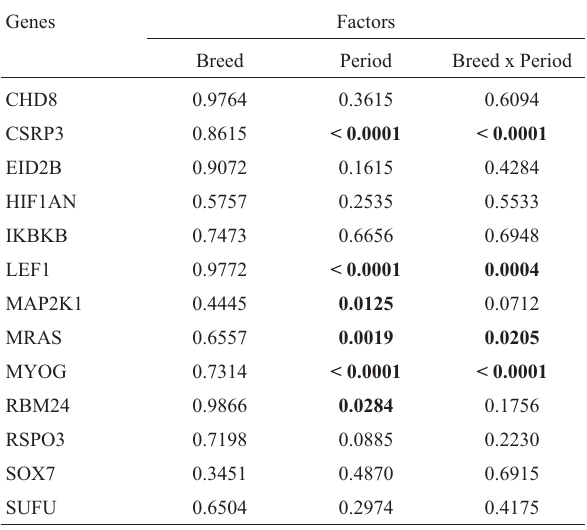
Table3 -P-valuesforANOVAinrelationtoBreed,Periodandinteraction Breed x Period for the genes studied.